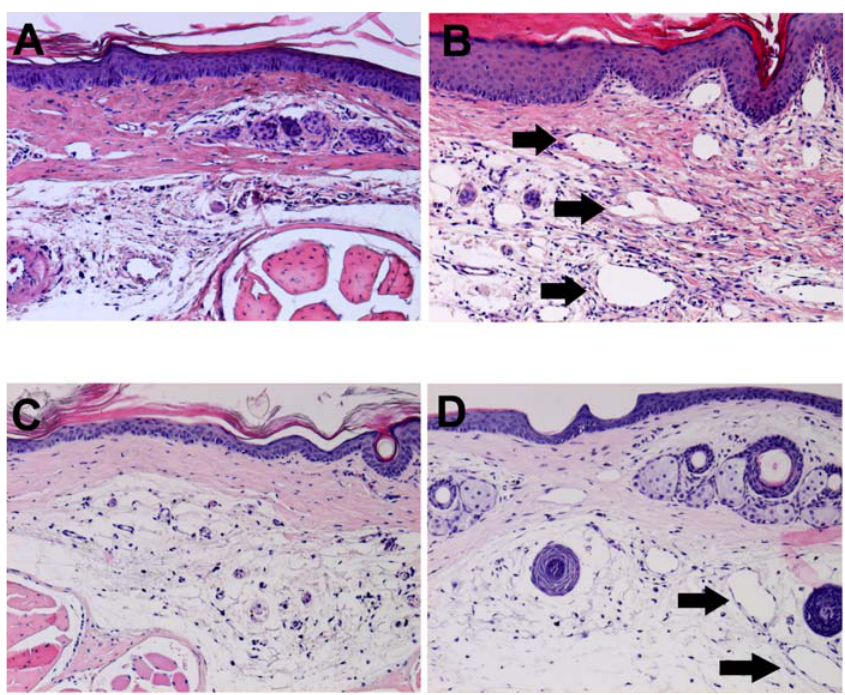
Figure 2. Histopathology of Experimental Lymphedema in the Murine Tail Lymphedema was characterized by the presence of marked acute inflammatory changes, both adjacent to the surgical site and within distal regions of the tail, remote from the site of surgical ablation. (A) Normal tail skin harvested 16 mm from the base of the tail is characterized by the presence of a thin dermis and epidermis, with a normal epidermal/ dermal junction. Surgical sham controls were indistinguishable from normals, with no increased cellularity in dermis or epidermis, and no enlarged nuclei or hyperkeratosis. (B) Lymphedematous skin harvested immediately distal to the site of prior surgical lymphatic ablation is characterized by the presence of marked acute inflammatory changes, absent in the tissue derived from the normal tails. There is a notable increase in cellularity, with an increase in the number of observed fibroblasts and histiocytes, as well as a large infiltration of neutrophils. There is hyperkeratosis and spongiosis and edema of the epidermis, with irregularity of the epidermal/dermal junction, elongation of the dermal papillae, and a 2- to 3-fold expansion of tissue between the bone and the epidermis. There are numerous dilated lymphatic microvessels in the dermis and subdermis (black arrows). In contrast, normal tail sections were devoid of these dilated structures. (C) Normal skin derived from the distal tail. No inflammation, hypercellularity, or lymphatic dilatation is observed. (D) Distal skin in lymphedema. Spongiosis and lymphatic microvascular dilatation (black arrows) are once again detectable. DOI: 10.1371/journal.pmed.0030254.g002 PLoS Medicine |